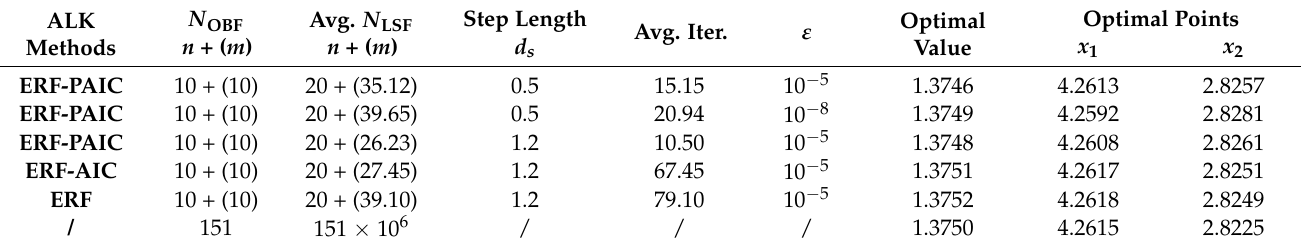
Table 2. The optimum point with systemic reliability constraints predicted by different models ( n is original number, m is number of adding